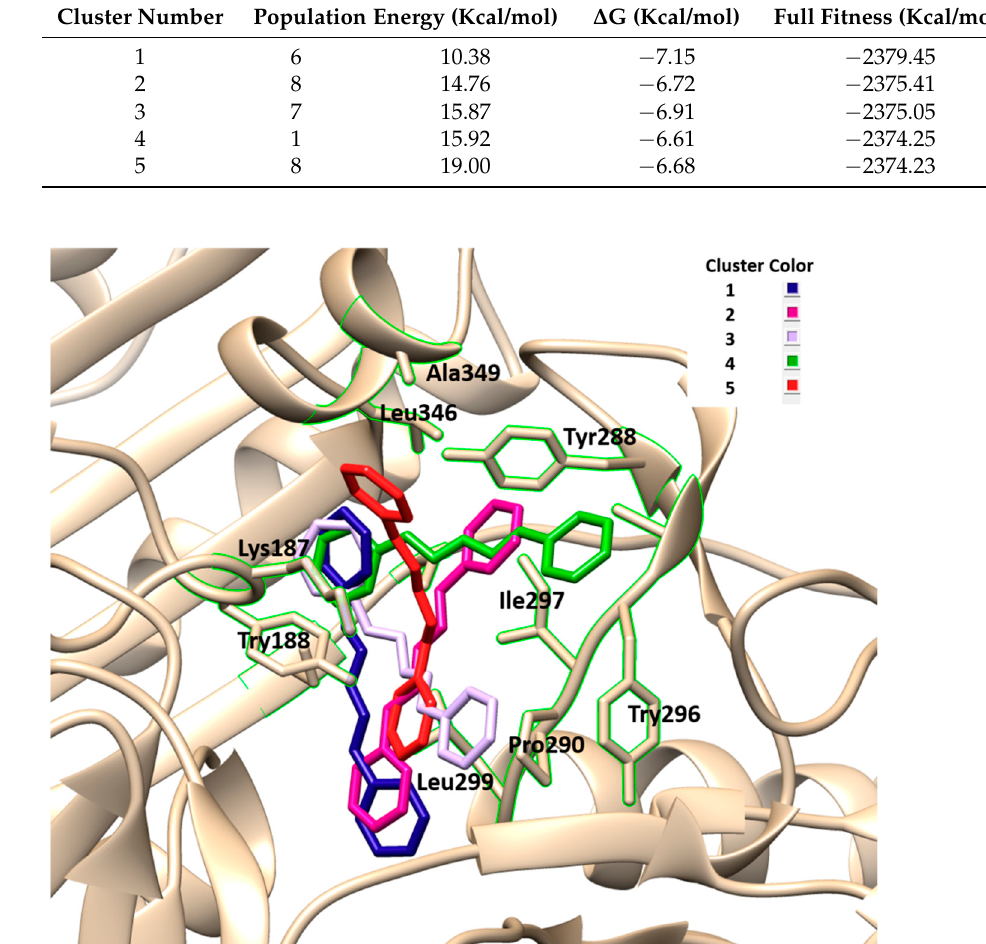
Figure 4. Solutions of the docking simulation of the NO with CPH obtained with the SwissDock server.